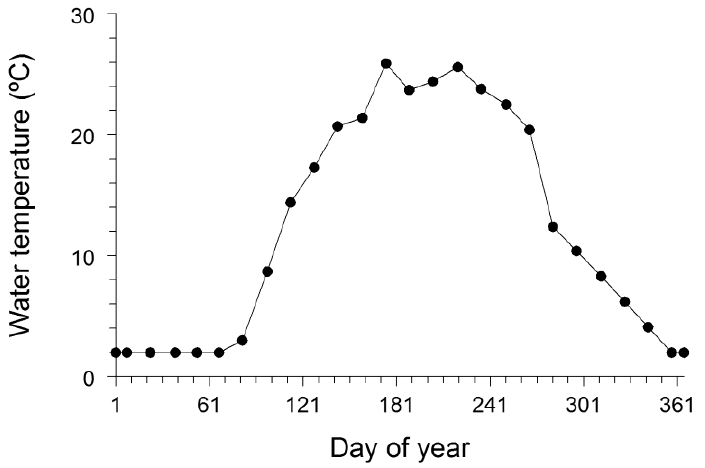
Figure 2. Water temperature regime used in the bioenergetics model application to growth data for bluegills in Squaw Lake (Oakland County, MI, USA). This water temperature regime was primarily based on daily water temperatures observed in Greens Lake (Oakland County, MI, USA) during 2009. Day 1 was 1 January, and day 365 was 31 December. See text for more